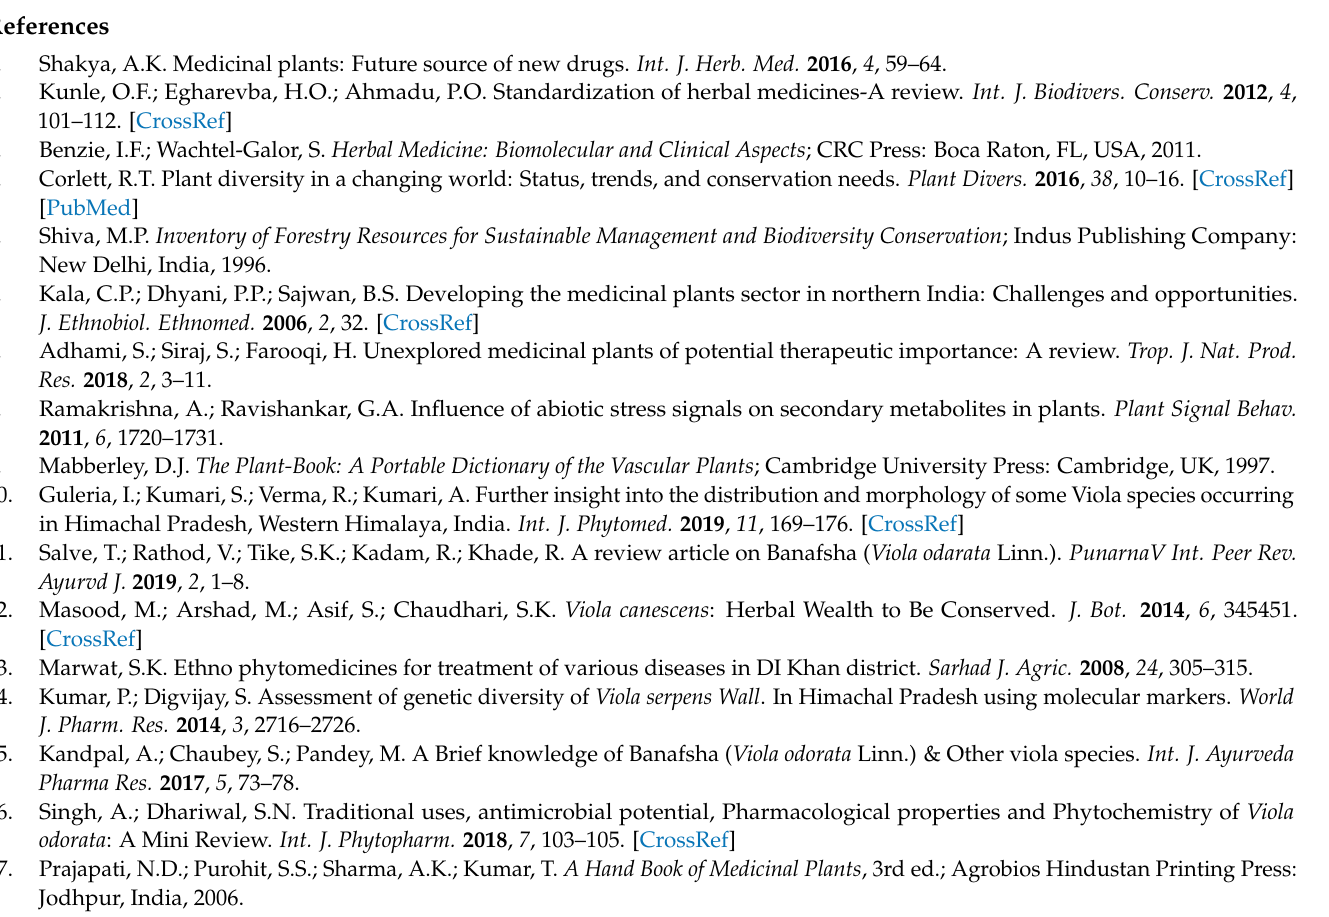
Figure S1. Micro-nutrients in Viola species at gradient altitudes (in ppm), Figure S2. Macro-nutrients in Viola species at gradient altitudes (in ppm); Figure S3. ABTS & DPPH based antioxidant activity of (IC50 µ g/mL) of Viola species; Figure S4a UPLC-DAD Chromatograms of flowers samples of Viola species (DKRL1-DKRL15); Figure S4b UPLC-DAD Chromato-grams of flowers samples of Viola species (DKRV1-DKRV15); Table S2. MIC’s of the most effective plant extract against S. aureus & B. subtilis ; Figure S5. Antimicrobial activity (Zone of inhibition of flowers and leaves) of Viola